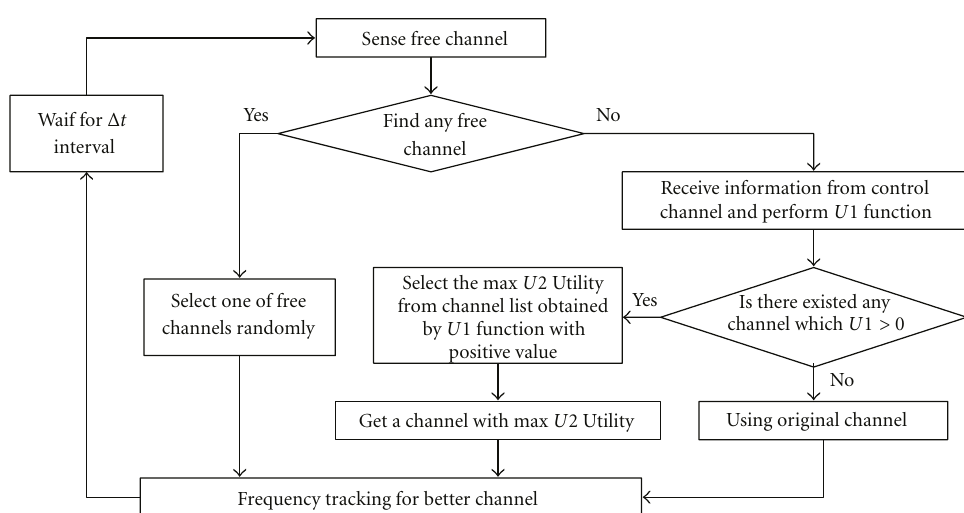
Figure 5: The work flow of Noncooperative Spectrum Sharing